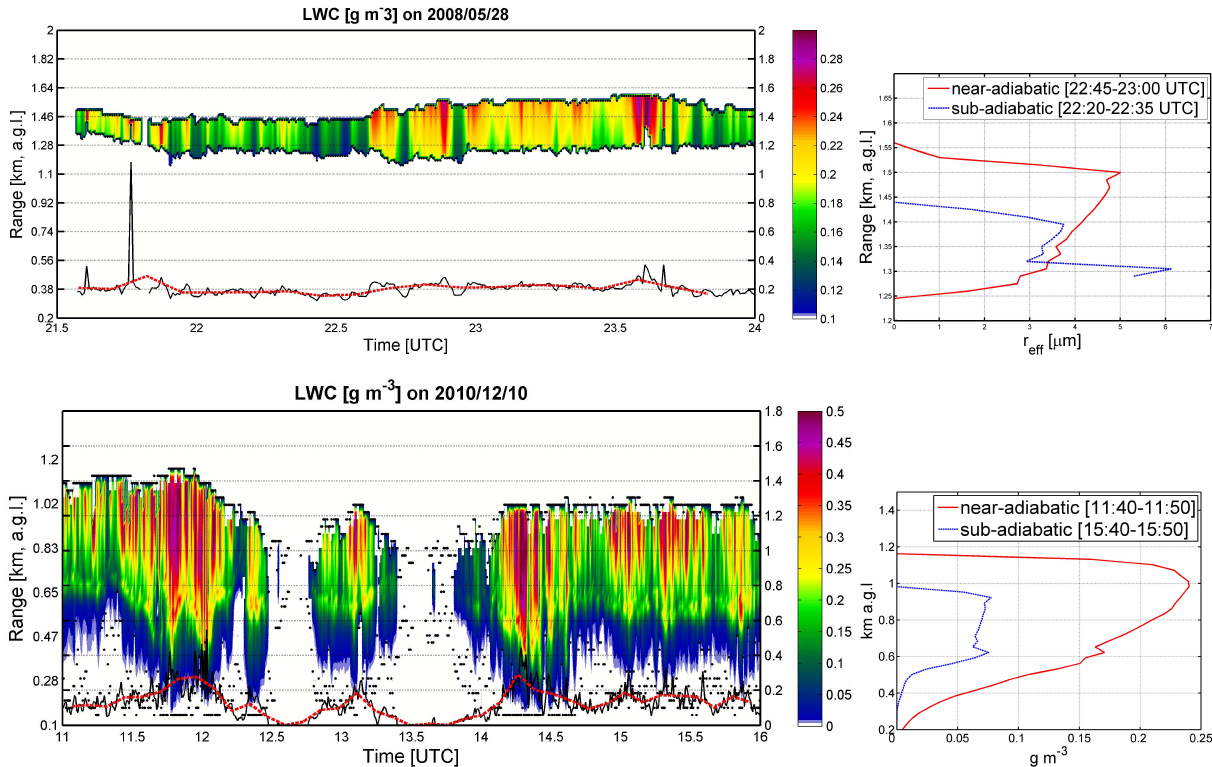
Fig. 10. Continental (top) and marine (bottom) case: time-height cross section of the liquid water content [gm − 3 ]. Layer-averaged black and red curves at each panel’s bottom (right y-scale in [gcm − 3 ]) have 0.5-min and 7.5-min temporal resolution, respectively. Profiles in highlighted frames show near-adiabatic (red) and sub-adiabatic (blue) LWC profiles corresponding to, respectively, maxima and minima of the departure function f (z)